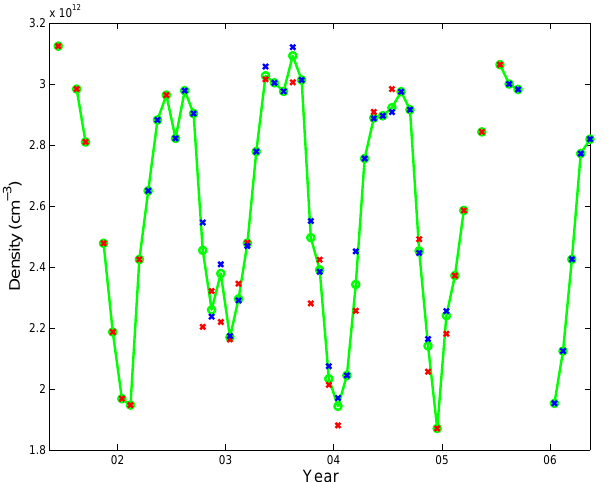
Fig. 11. The t values for the difference of trend terms at different latitudes and altitudes as a function of the inflection